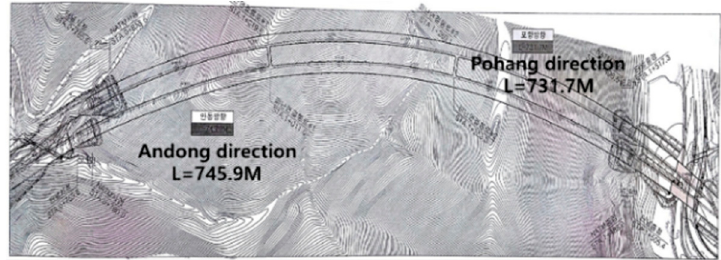
Figure 2. Longitudinal section of project A.